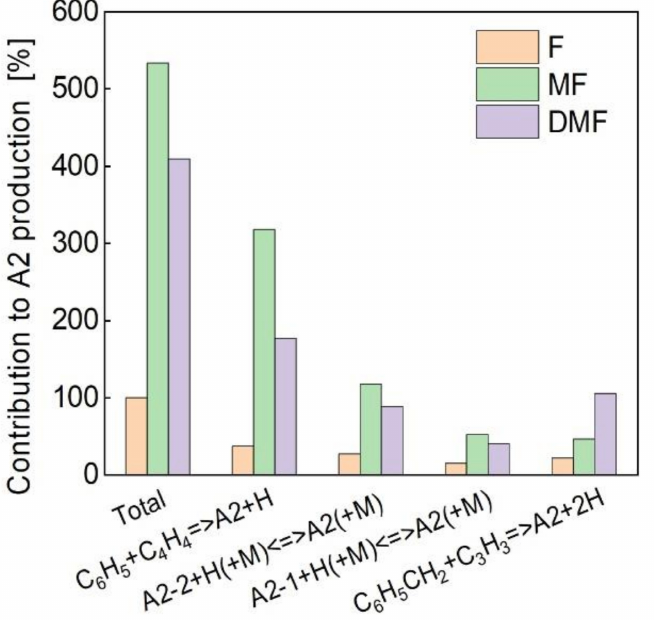
Figure 10. Percentage contribution from each reaction to A2 production for the furan, MF, and DMF flames.